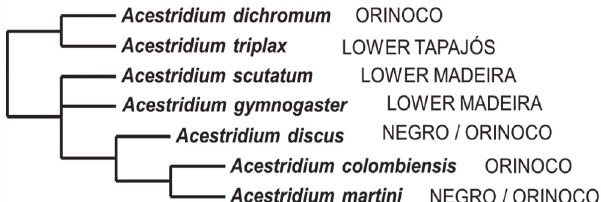
Fig. 11 . Geographic distribution of each species of Acestridium by main river